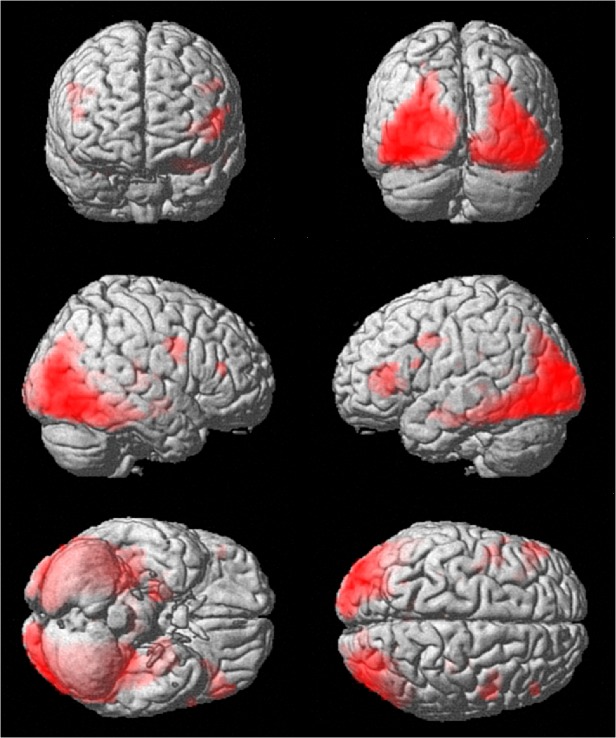
Whole brain activation.Whole brain activation related to encoding novel pictures during the picture encoding task, overlaid on a customized template (Template-O-Matic). Activation is thresholded at p<0.05, FDR-corrected.